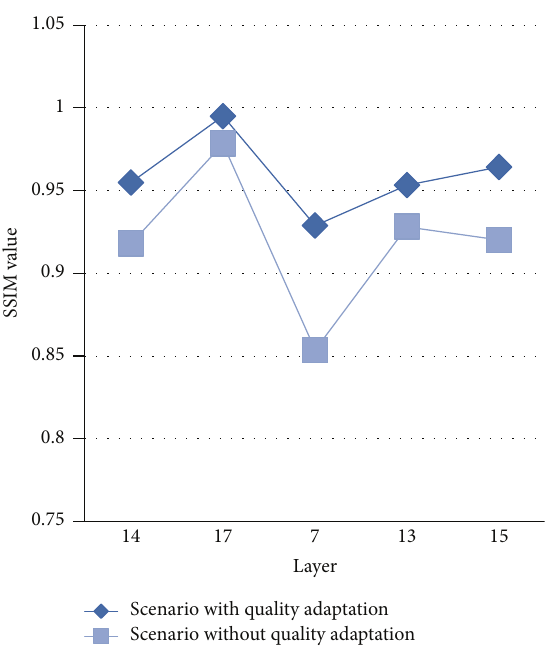
Figure 7: SSIM values in the scenario without quality adaptation and with quality adaptation by